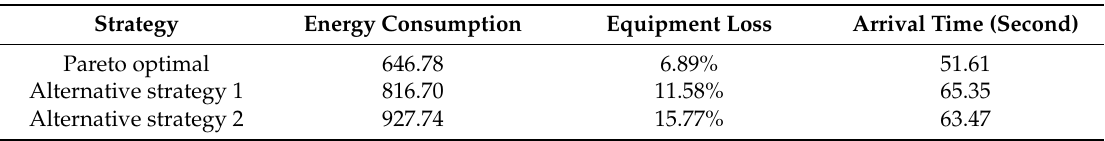
Table 7. The evaluation for Pareto optimal and alternative